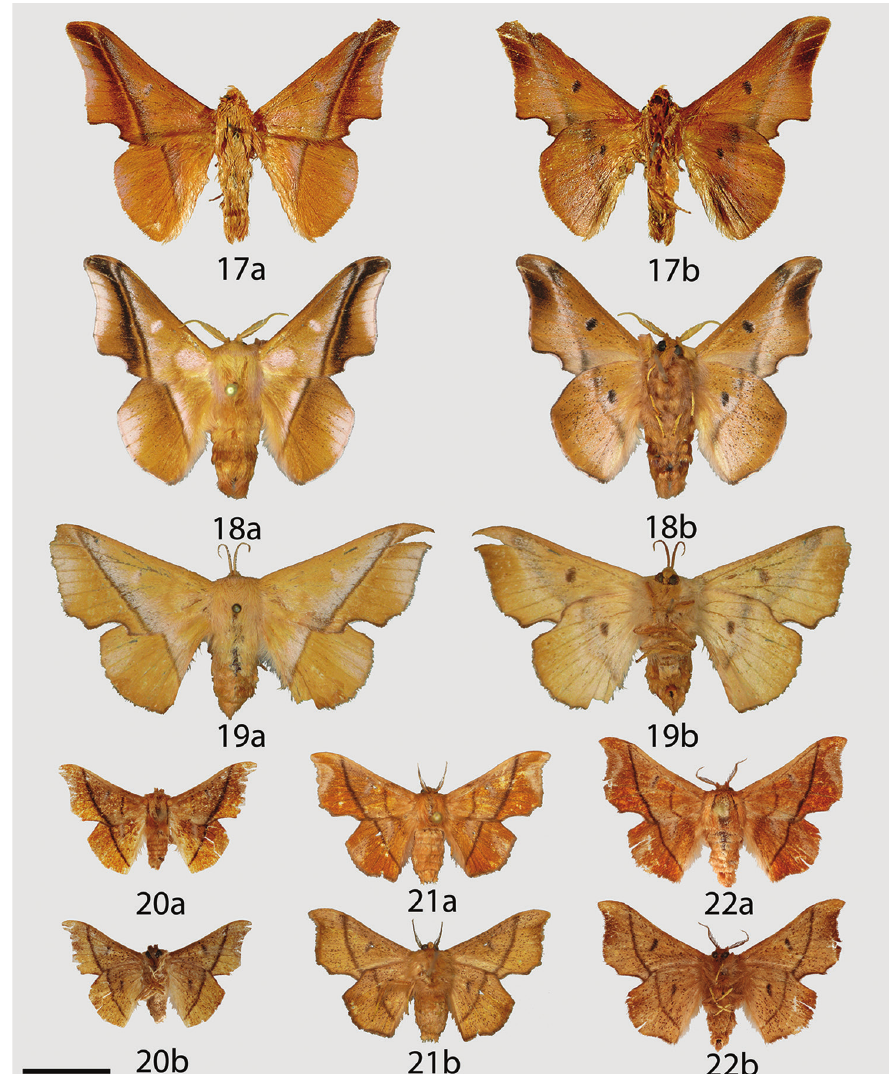
Figures 17–22. Reinmara adults, a dorsal b ventral. 17 R. minasa Holotype ♂ , Brazil, Minas Gerais, Passa Quatro (MNHU) 18 R. minasa ♂ , Brazil, São Paulo, São José do Barreiro, Bocaina, 1539 m